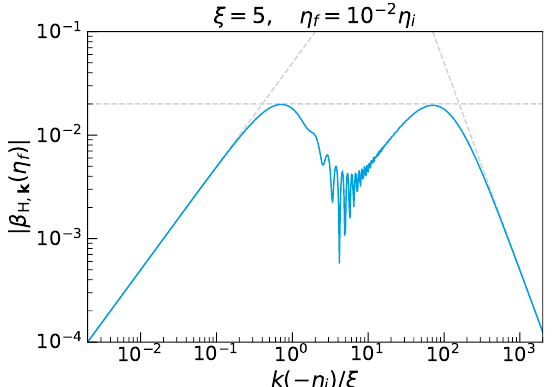
Figure 2 . The Bogolyubov coe(cid:14)cient (cid:12) H ; k for (cid:24) = 5 and (cid:17) f = 10 (cid:0) 2 (cid:17) i . The blue line is obtained by numerically solving eq. (4.8) without the Born approximation (see appendix D). The gray dashed lines are the approximate solution